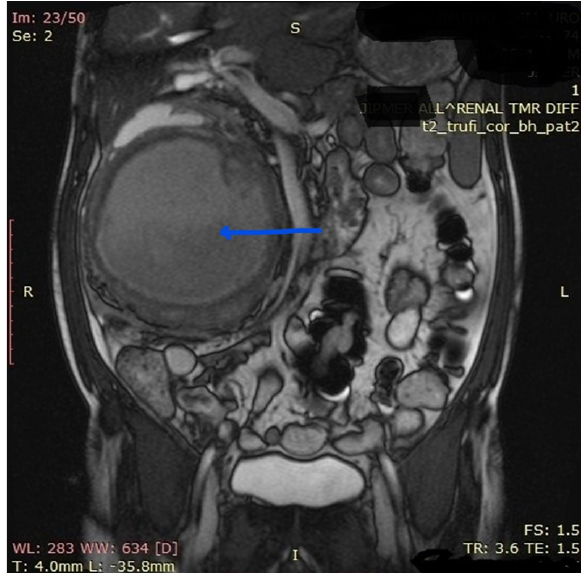
Figure 1: MRI of the abdomen and pelvis showing heterog- enous hypointense large right renal mass, arising from lower pole, fat plane maintained with liver, IVC compressed by mass and pushed laterally.